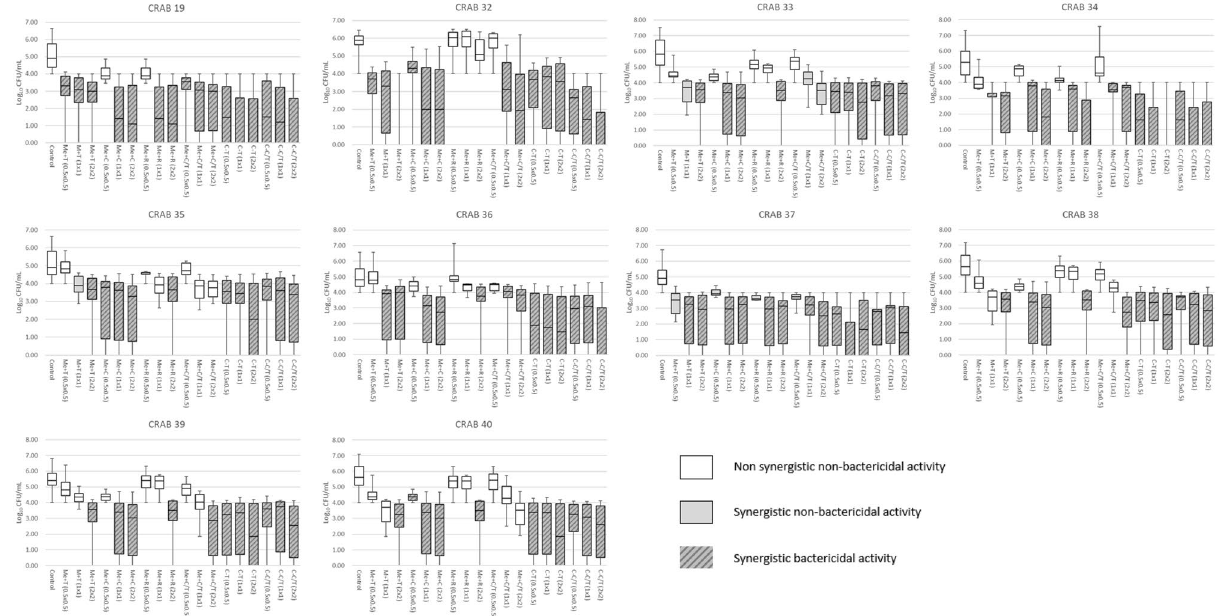
Figure 2. Time-kill curves of the 10 Acinetobacter baumannii isolates for six combinations of antibiotics with the different concentrations. C, colistin; C/T, ceftolozane/tazobactam; Me meropenem, R rifampin, T